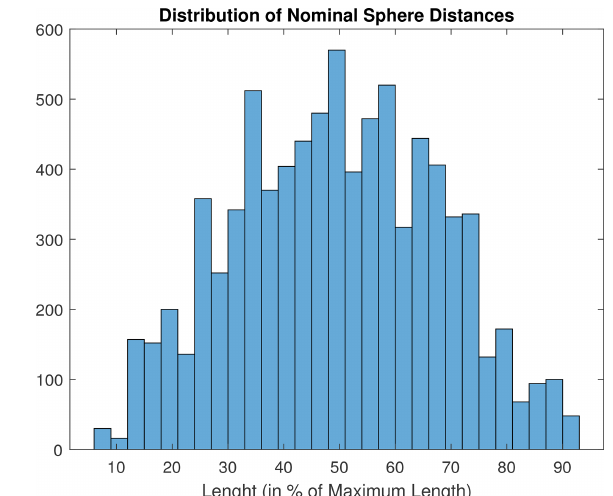
Figure 4. Distribution of the nominal sphere centre-to-centre dis- tances in the simulation artefact. While the range of ≈ 35% to 65% is represented by more lengths, there are still a considerable number of short and long lengths within the